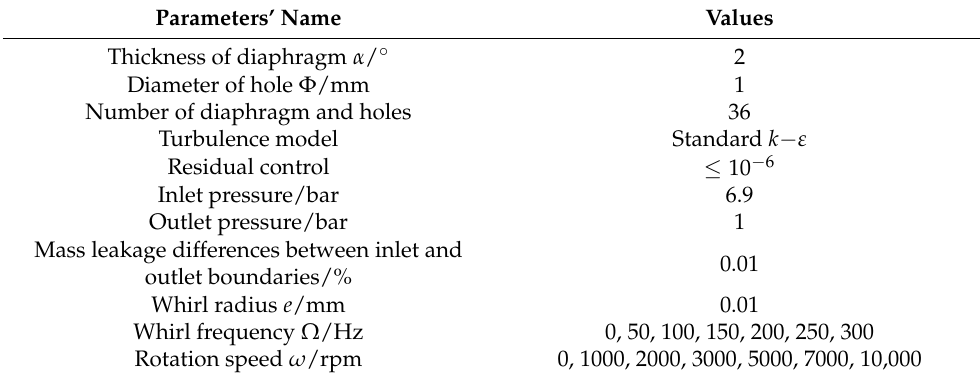
Table 2. Simulation values of HDLS.